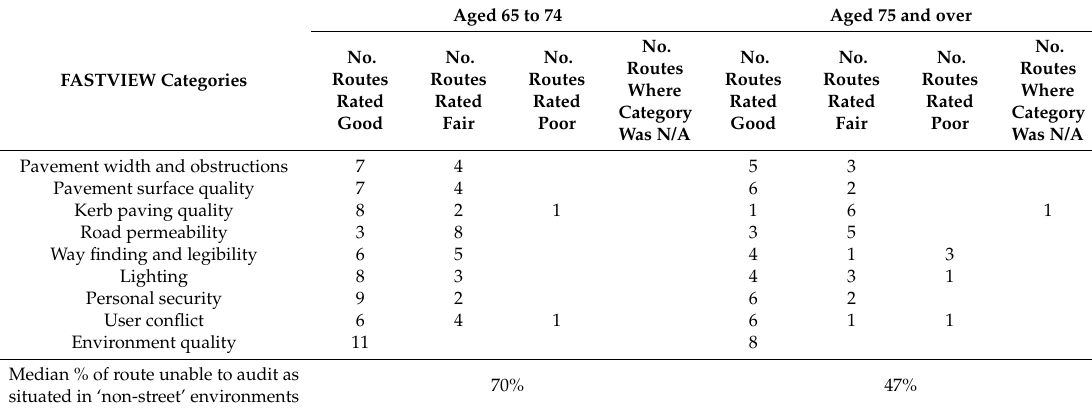
Table 4. Route walkability scores by